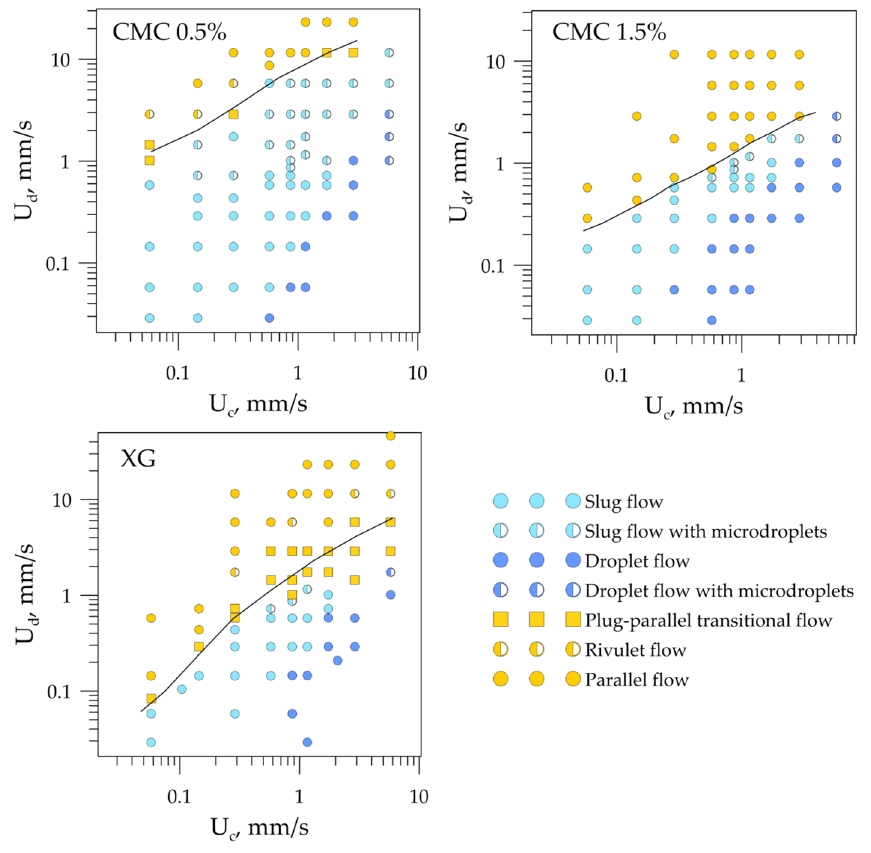
Figure 4. Flow-pattern maps for liquid–liquid flows when the dispersed phase was non-Newtonian.